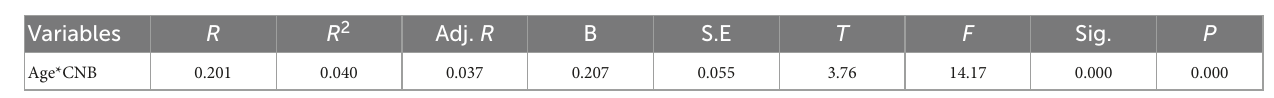
TABLE 2 Linear regression results.